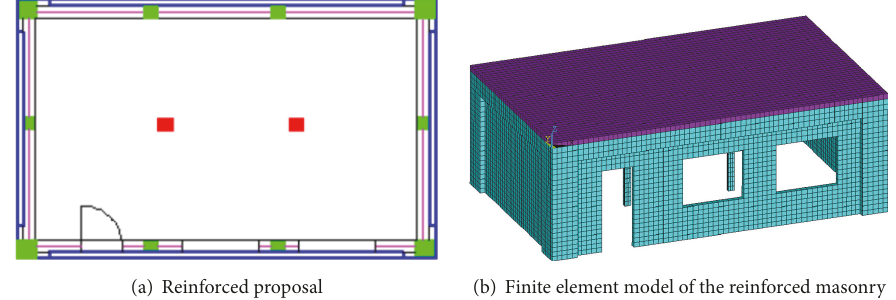
Figure 12: Reinforced proposal and finite element model of the masonry